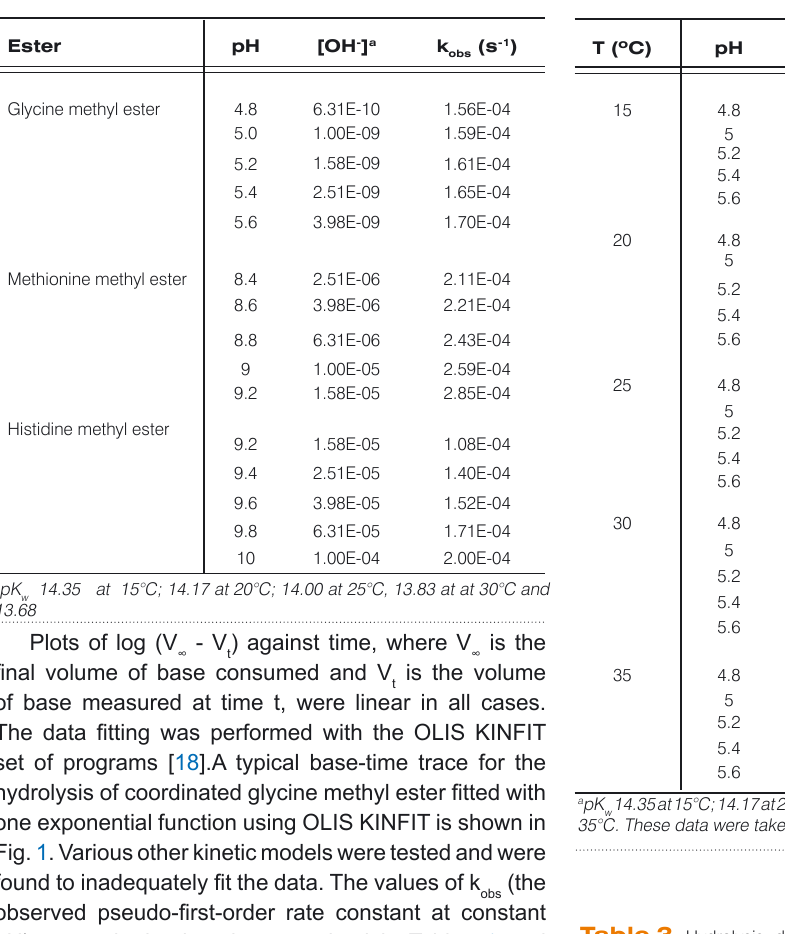
Table 1. Kinetics of the hydrolysis of [Pd(pip)(ester)] 2+ at 25°C and 0.1 M ionic strength. Ester pH [OH - ] a k Glycine methyl ester